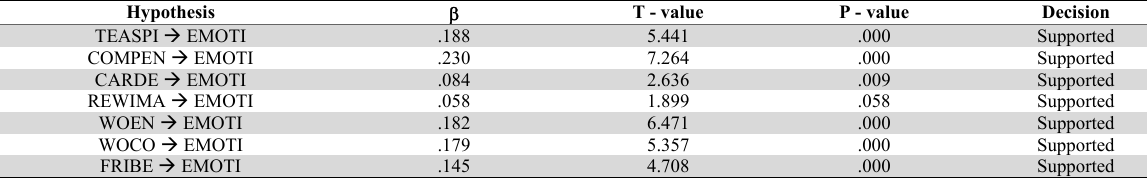
Effect Coefficients between Independent Variables and Employee